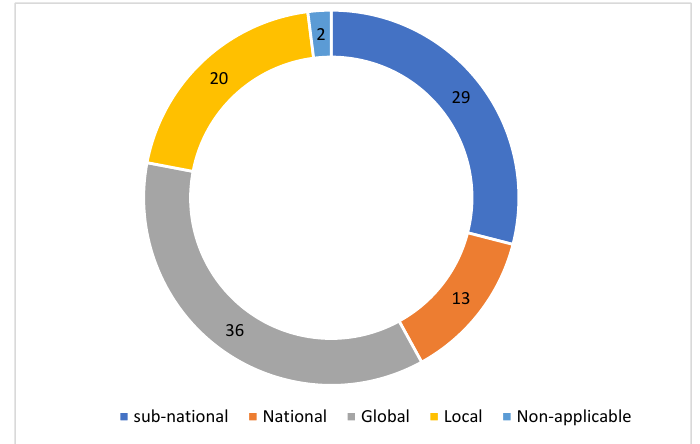
Figure 4. Scale of analysis of sampled studies (in percentages).